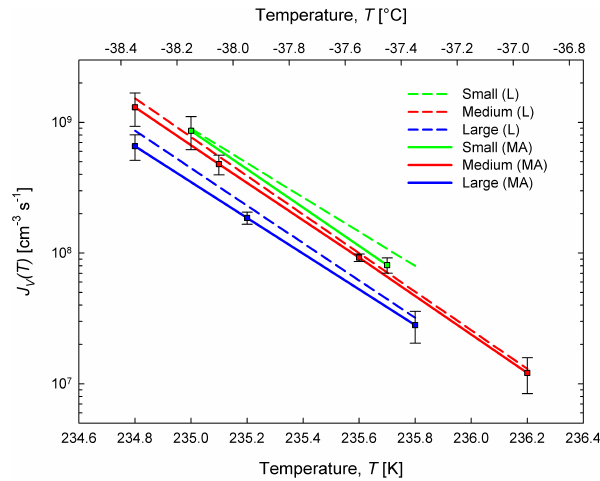
Fig. A2. Comparison of J V (T ) curves from model simulations us- ing layers (L) to represent different temperature and velocity pro- files in the flow tube with curves from simulations employing cross- sectional and mass-averaged temperature profiles